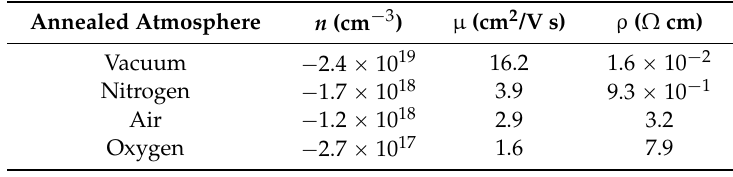
Table 2. Electrical properties of n ‐ ZnO films annealed at 700 °C under vacuum, nitrogen, air, and oxygen atmospheres, respectively, for 30 min.